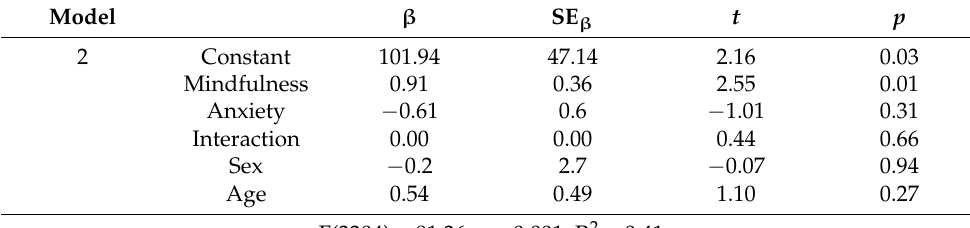
Table 4. Model coefficients that consider anxiety as an independent variable.